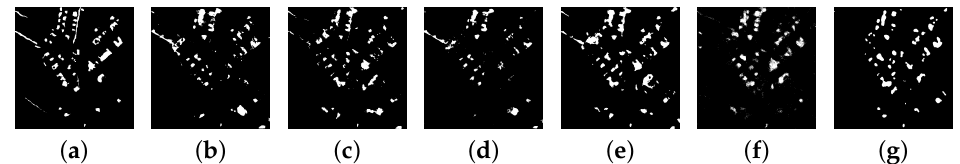
Figure 14. Result examples of different change detection algorithms on the Szada of SZTAKI dataset. ( a ) ground truth map, ( b ) FC-Siam-conc, ( c ) FC-Siam-diff, ( d ) U-Net, ( e ) DSMS-CN, ( f ) SNUNet, ( g )